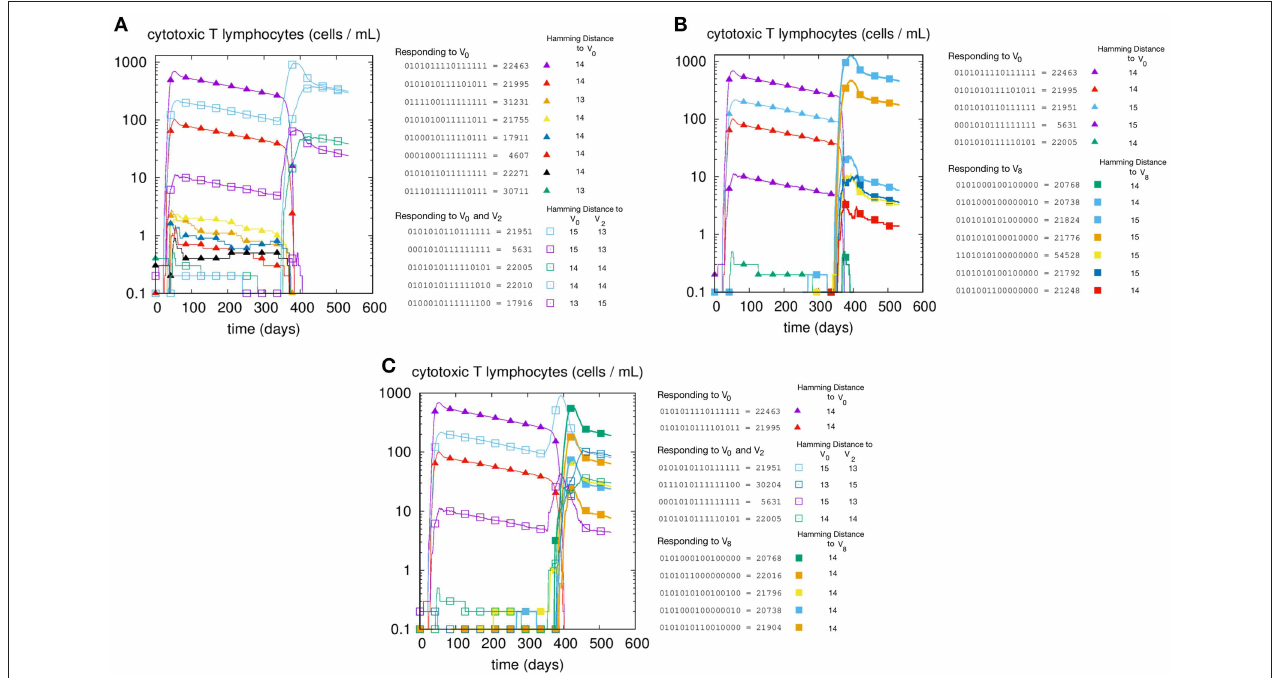
FIGURE 1 | T-cell counts corresponding to three different but similar simulations. In panel (A) we inject two homologous viruses (i.e., cross-reacting) in succession (i.e., at day t I = 0 and t II = 330) namely V I = V 0 , V II = V 2 , which are therefore at a distance of 2 bits. In panel (B) we inject two heterologous viruses, V 0 and V 8 . In panel (C) instead, after the usual priming with V 0 we challenge the system with both the homologous V 2 and the heterologous V 8 viruses. Cell counts shown in all panels are representative of the most active clones of the 2 N possible. These “responding clones” are specific either to just V 0 (filled triangles in all panels A–C ), or specific to both V 0 and V 2 (i.e., cross-reacting memory clones shown in panels A,C as empty squares), or naïve independent responses specific to V 8 (panels B,C , filled squares). In panel A the primary naïve response to V 0 (filled triangles) leaves memory that is then re-stimulated by V 2 . In panel B instead, the same primary naïve response to V 0 (filled triangles) do not cross-react to V 8 and indeed fade away upon the raising of the secondary responses. (C) shows what happen when the system is challenged with both. It shows in particular that the heterologous response to V 8 (filled squares) is independent and unaffected by the cross-reacting clones (empty squares) operating the